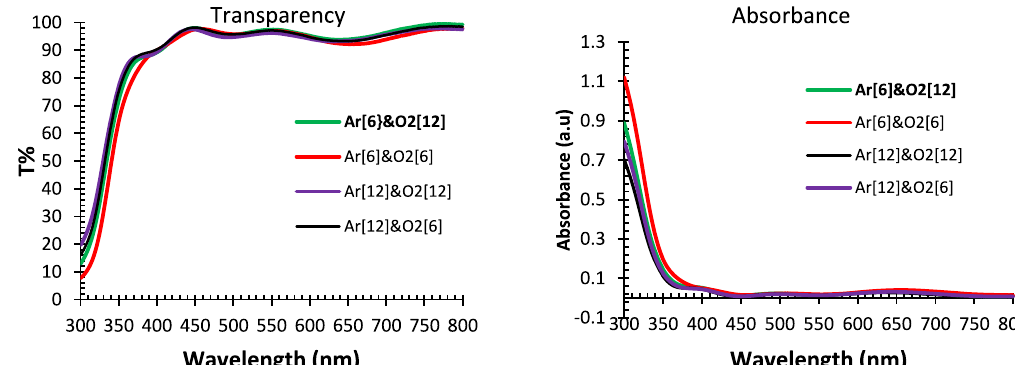
Fig. 7. Optical properties of C-TiO 2 coated FTO glass prepared at different ratios of Ar and O 2 (a) transparency (b) absorbance.